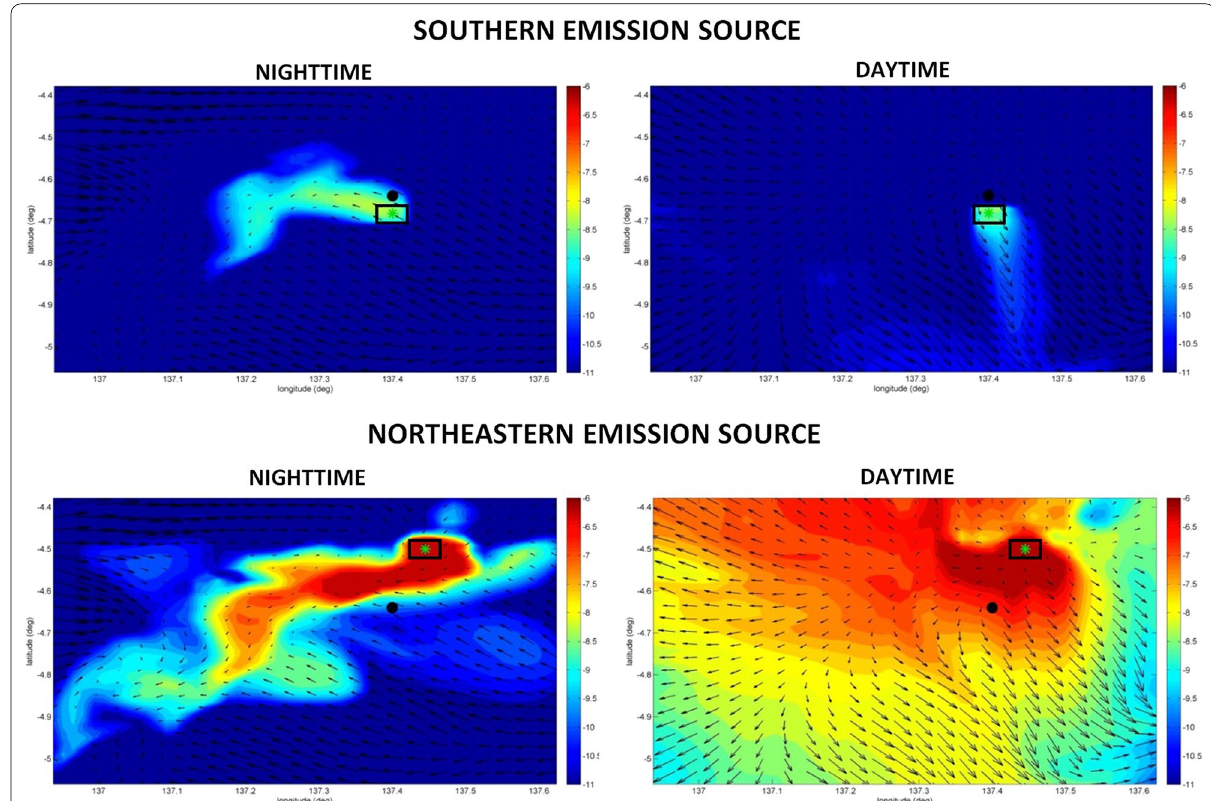
Fig. 7 Surface methane mixing ratio (output from the first vertical model level at 10 m) in the vicinity of the MSL in logarithmic scale, both during nighttime (0:00 h LTST) and daytime (12:00 h LTST) produced by two different sources at different locations (locations 18 and 47) relative to the MSL (represented by a black dot). The emission area is represented by a square. Both emission sources present similar methane abundances, in accordance with MSL’s observations (~ 1 ppbv or less, Webster et al. 2018) during nighttime; however, the unfavorable air mass transport during the night for the northwestern emission source (location 47, bottom panels) requires a much higher emission flux to match MSL’s observations. It implies that the extremely favorable anabatic flows blowing over the slopes of Aeolis Mons, and the development of the planetary boundary layer, during daytime, produce a sustainable increase in the methane abundance at MSL’s location to values of the order of 100 ppbv, which is not what has been observed at all (Webster et al. 2015;